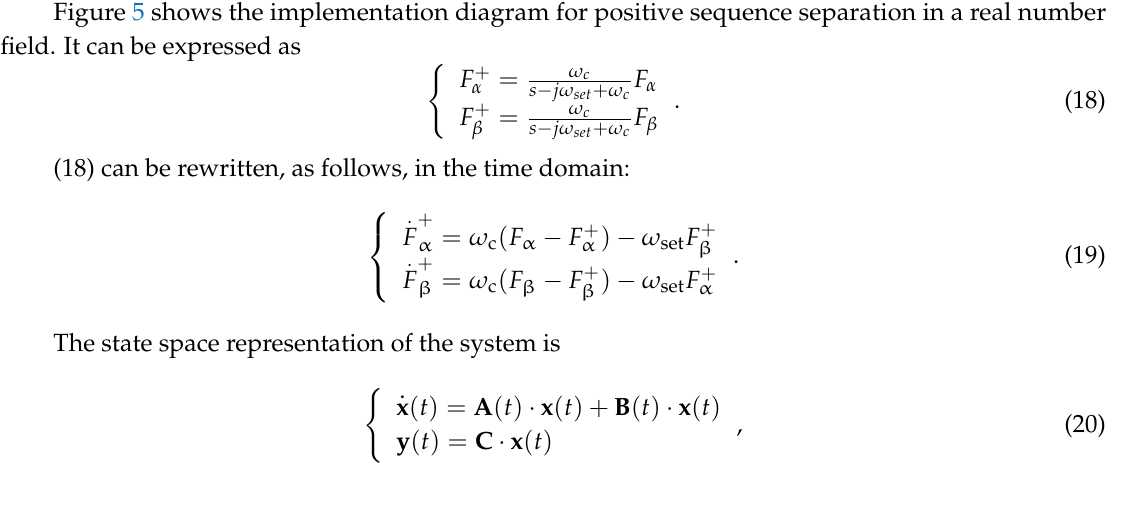
= 100 π rad/s). set